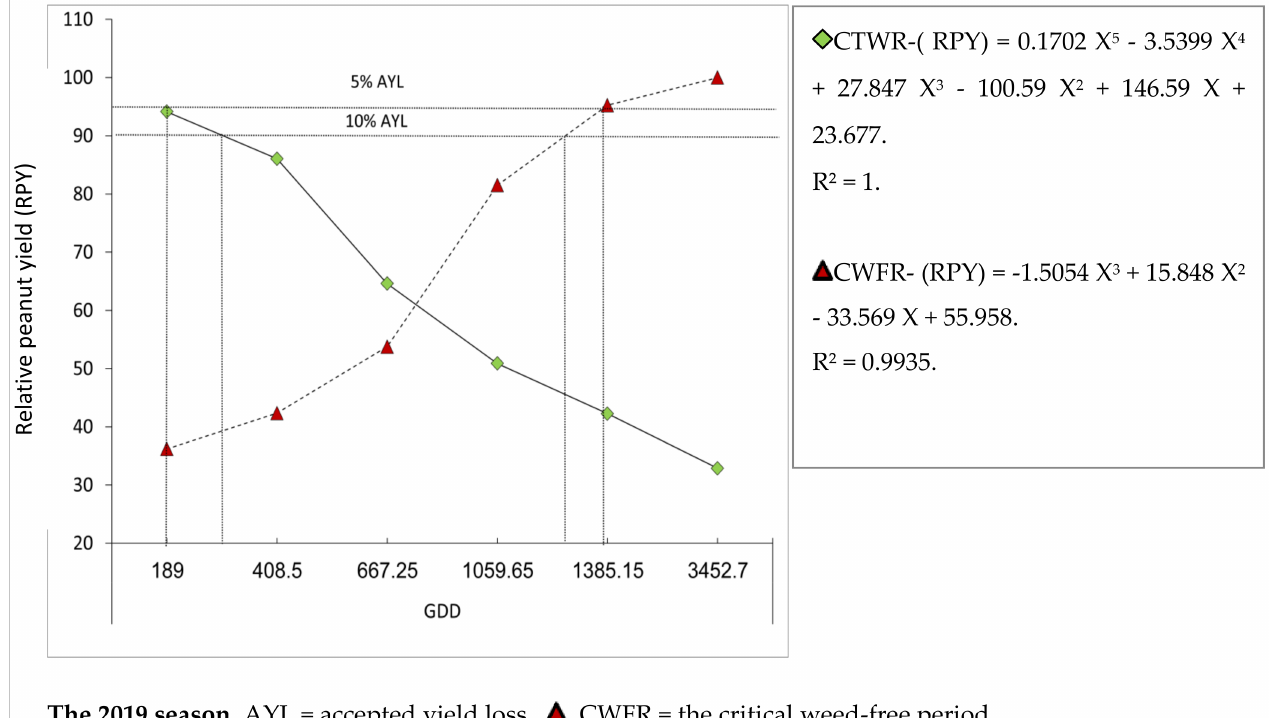
The 2019 season. AYL = accepted yield loss. Figure 1. Impact of dry total annual weeds interference on relative yield level of peanut in 2018 and 2019 seasons. Increasing duration of dry total annual weeds interference ( ), increasing dry total annual weeds free period ( ), the polynomial equation expresses data for relative yield. The dots and the lines point to relative peanut yield and fitted models, respectively. AYL = accepted yield loss, RPY = relative peanut yield.